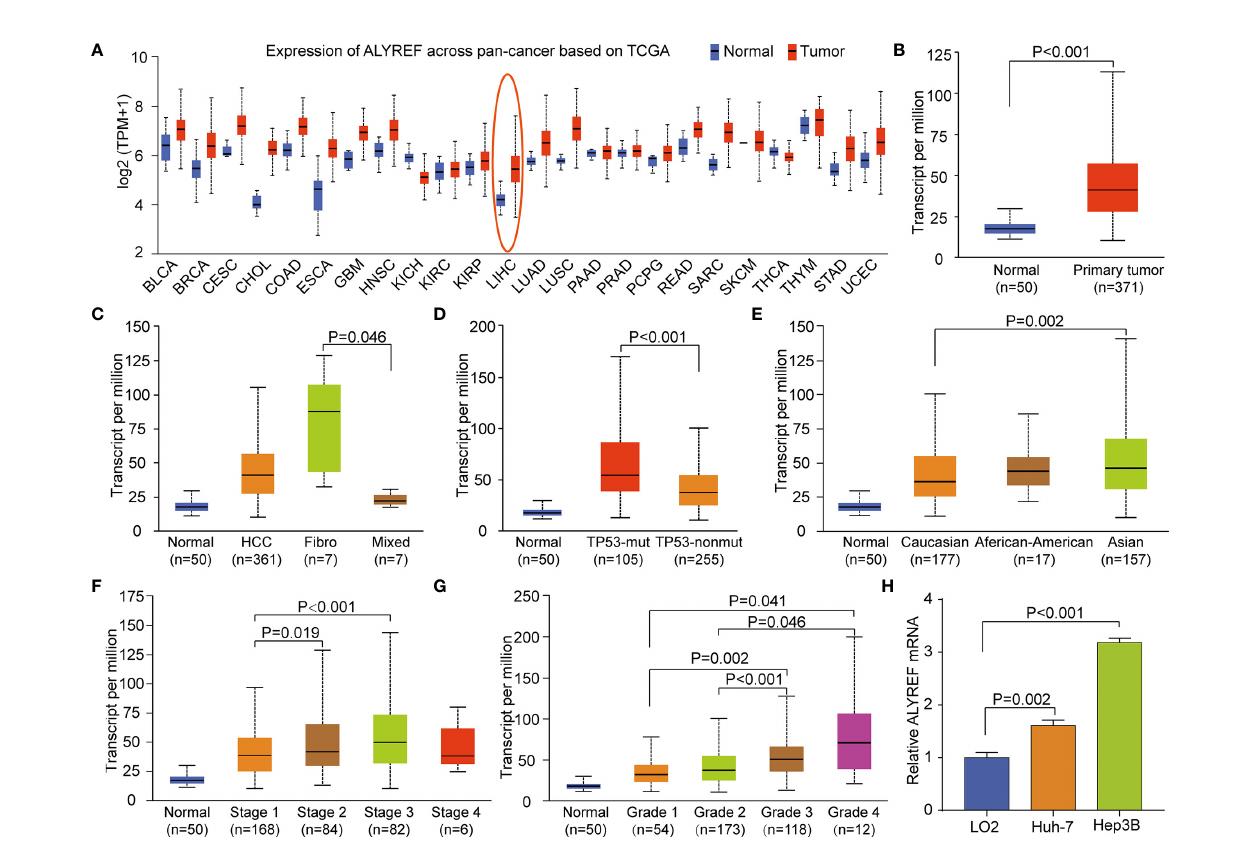
FIGURE 1 | Increased pan-cancer ALYREF mRNA expression and in liver hepatocellular carcinoma (LIHC) subgroups based on clinical characteristics. (A) ALYREF was increased in pan-cancer tissues compared to normal tissues, especially in LIHC. (B) ALYREF mRNA expression was signi fi cantly increased in primary tumors compared to normal tissues. (C – G) The transcription levels of ALYREF in different clinical trait-based groups. The speci fi c groupings were based on pathophysiology, TP53 mutation status, race, clinical stages, and clinical grades. (H) The expression levels of ALYREF mRNA were increased in Huh-7 and Hep3B cell lines compared to normal liver cell line